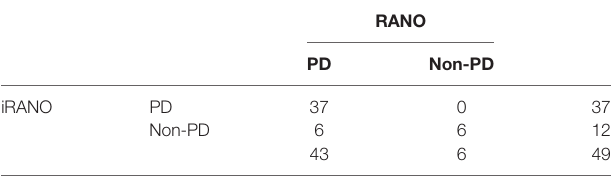
TABLE 2 | Confusion matrix of PD status by iRANO and RANO (n =